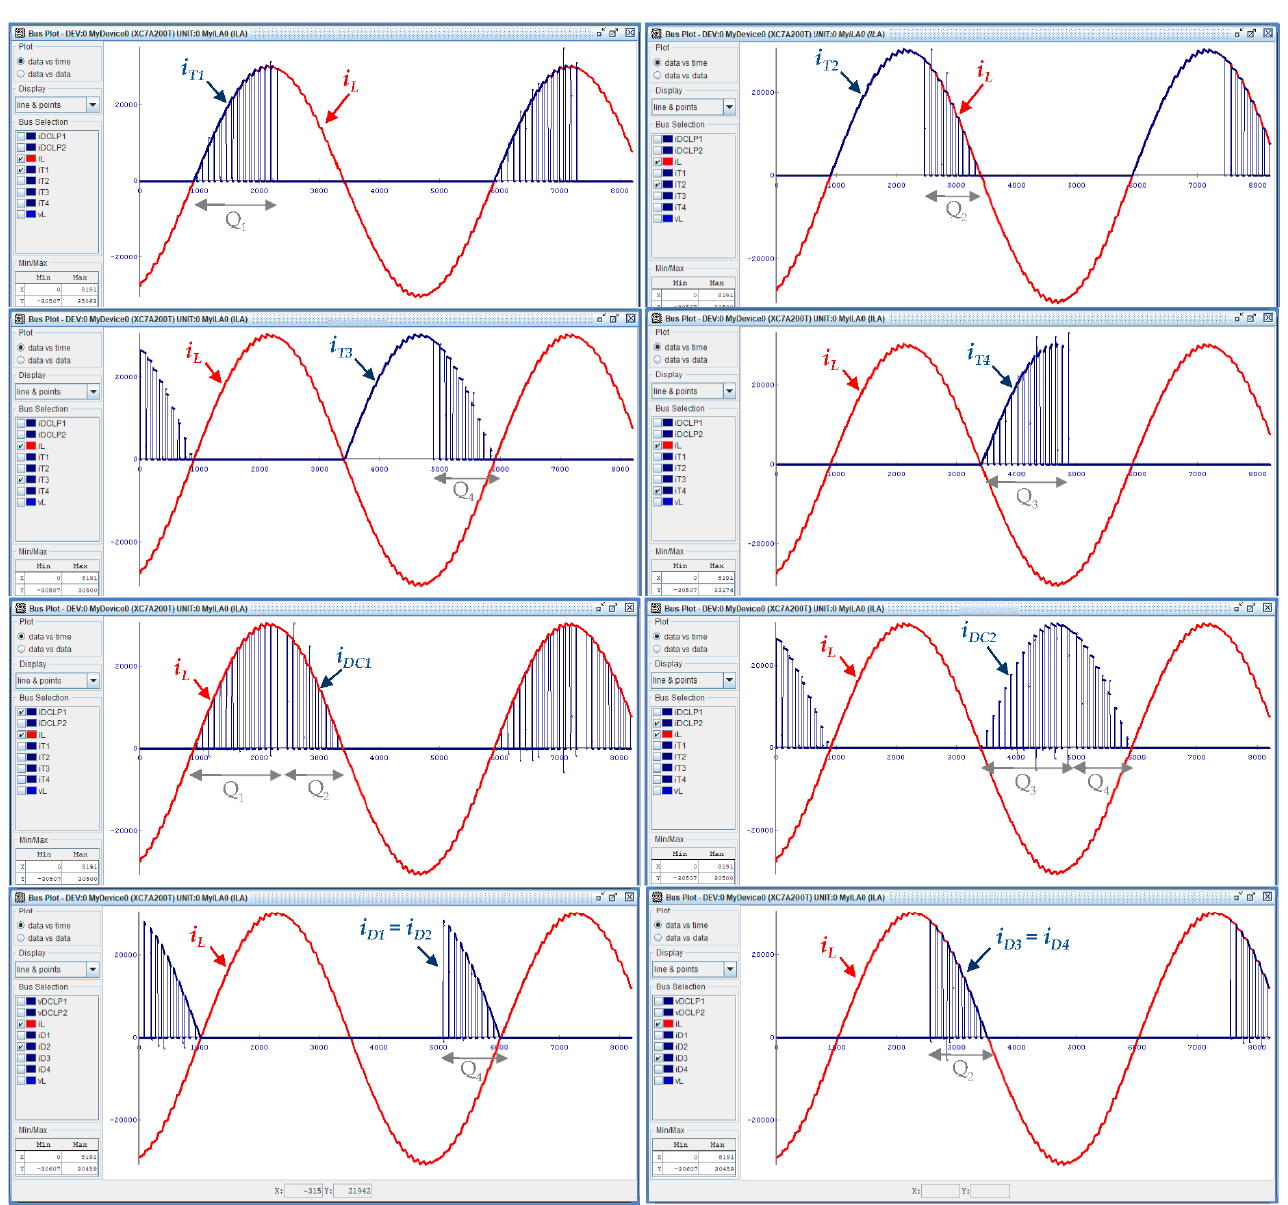
Figure 12. RT results for the half-bridge NPC inverter—waveforms of the power switches currents